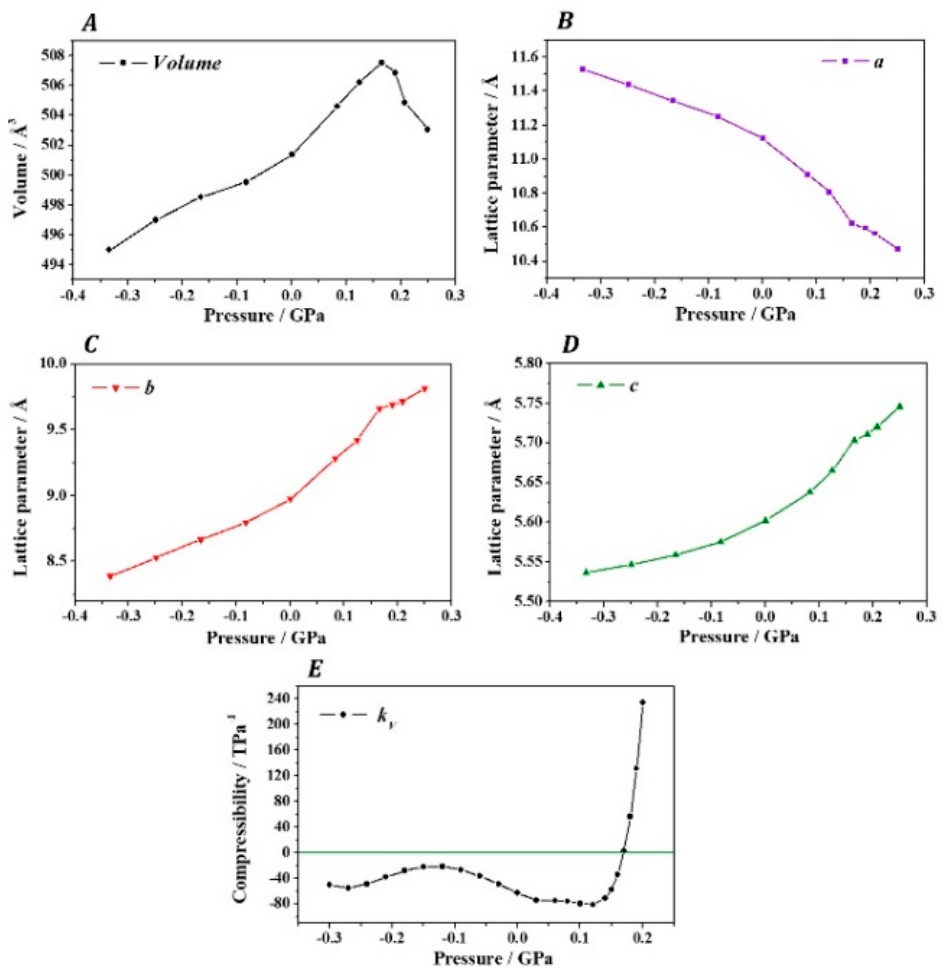
Figure 6. ( A ) Computed unit cell volume of copper squarate as a function of the external stress applied along the [1 0 0] crystallographic direction; ( B ) a lattice parameter; ( C ) b lattice parameter; ( D ) c lattice parameter; ( E ) Volumetric compressibility, k V = − 1/ V · ( ∂ V / ∂ P ) P